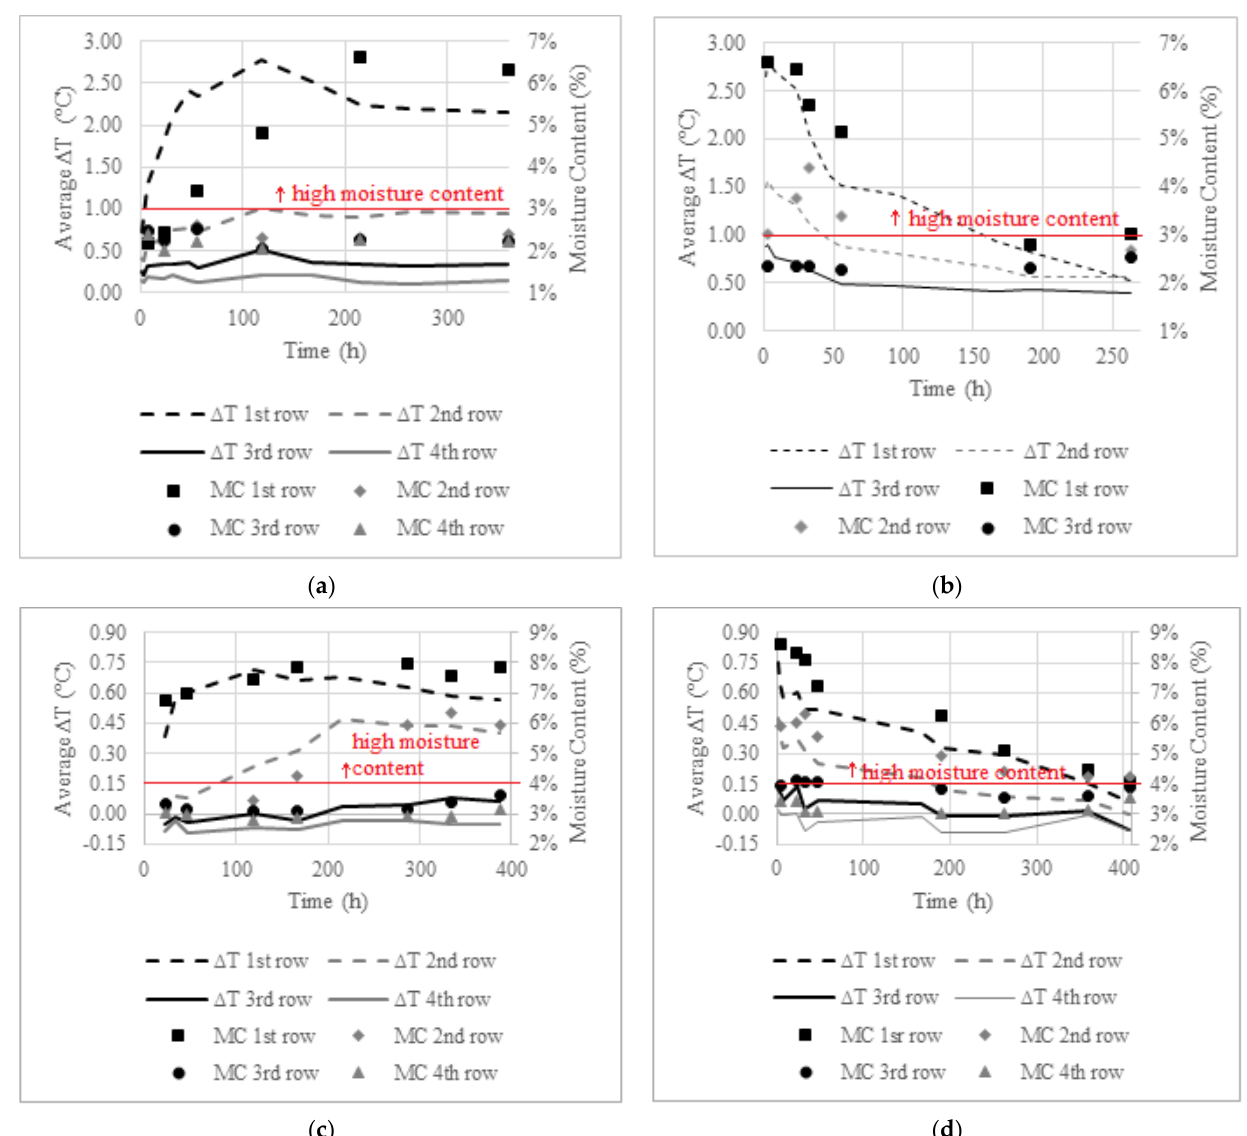
Figure 10. Average ∆ T and moisture content (MC): ( a ) humidification—hot chamber; ( b ) drying—hot chamber; ( c ) humidification—cold chamber; ( d ) drying—cold chamber.